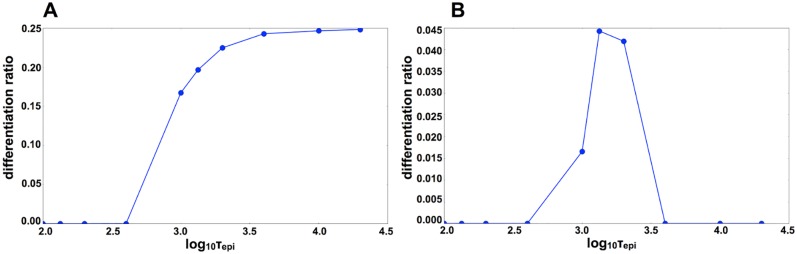
Effect of the time scale of the epigenetic variable τ
epi.Here, the differentiation ratio is plotted against τ
epi. We conducted a differentiation simulation by running the epigenetic model 1000 times for each time scale, and then counted the number of differentiated cells (x
1 ∼ 0). The average differentiation ratio (i.e., the vertical axis) represents the percentage of differentiated cells per simulation. To run the simulations, we used identical values to those used in Fig 6. A: Given strong cell-cell interaction (D = 2.0), our model showed differentiation without the epigenetic variable. Thus, a large time scale did not negatively affect differentiation. However, given a smaller time scale, cellular differentiation did not occur because the cellular state was quickly fixed. B: Given weak cell-cell interaction (D = 1.5), there was a peak around the time scale of the epigenetic variable τ
epi ∼ 5.0 × 103. If the time scale of τ
epi was small (τ
epi < 103), the cellular state was quickly fixed and differentiation did not occur. Conversely, if the time scale τ
epi was large (τ
epi > 104), oscillation remained in place.